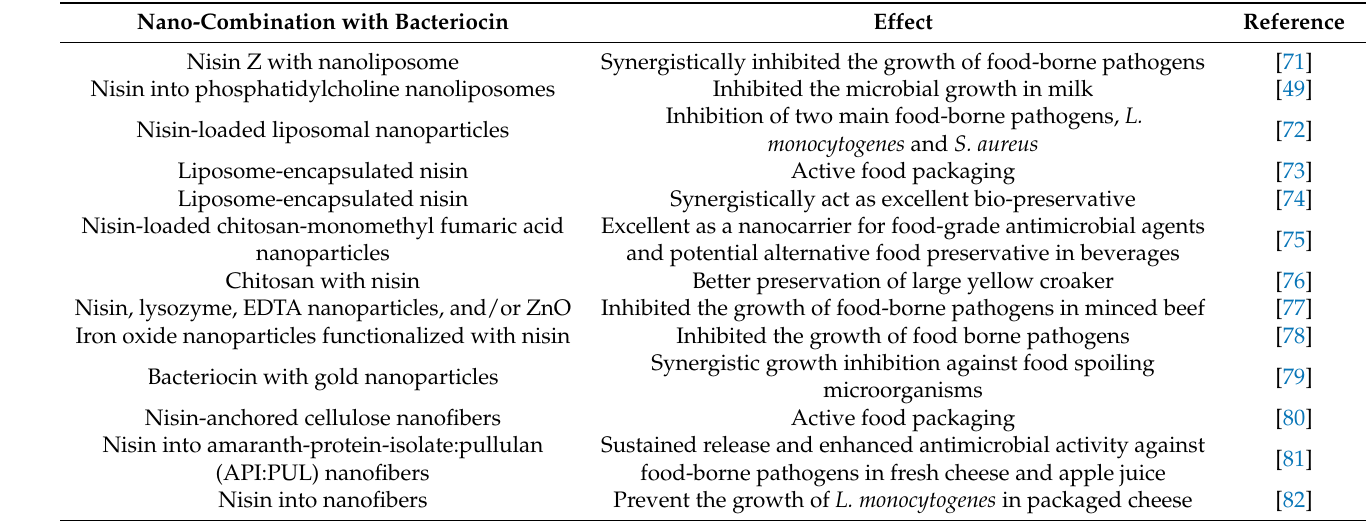
Table 1. Various food related applications of nano-combination with